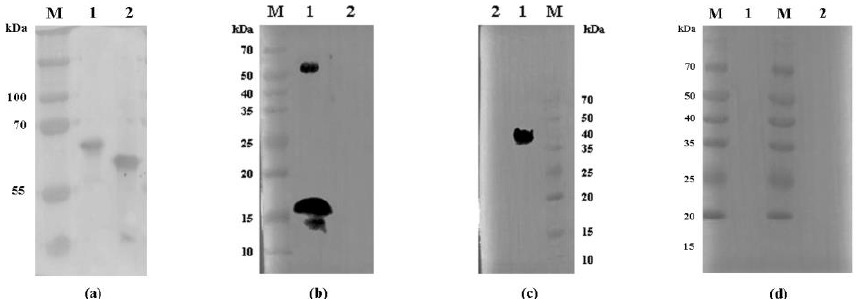
Figure 2. Western blot analysis of recombinant Cpgp40 / 15 and Cpgp40 in E. coli and native Cpgp40 / 15 and Cpgp40 in C. parvum sporozoites. ( a ) Expression of recombinant Cpgp40 / 15 and Cpgp40 in E. coli assessed by Western blot analysis using an anti-GST tag. Lane M: protein size makers. Lanes 1,2: lysate from bacterial cells transformed with pGEX-4t-1-Cpgp40 / 15 or pGEX-4t-1-Cpgp40 with IPTG induction, respectively. ( b ) Western blot analysis of native Cpgp40 / 15 in C. parvum sporozoites. Lane M: protein size makers. Lane 1: native proteins from sporozoites. Lane 2: proteins from human ileocecal adenocarcinoma (HCT-8) cells. ( c ) Western blot analysis of native Cpgp40 in C. parvum sporozoites. Lane M: protein size makers. Lane 1: native proteins from sporozoites. Lane 2: proteins from HCT-8 cells. ( d ) Western blot analysis of native Cpgp40 / 15 and Cpgp40 using pre-immune serum. Lane M: protein size makers. Lanes 1,2: native proteins from sporozoites.